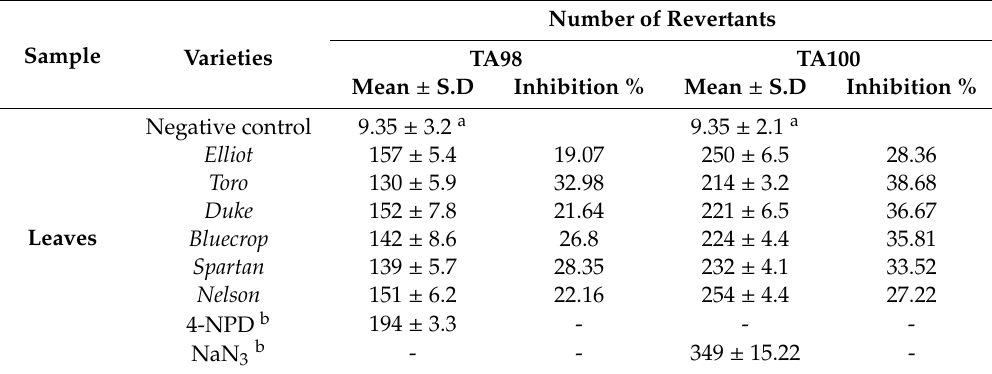
Table 5. Antimutagenic